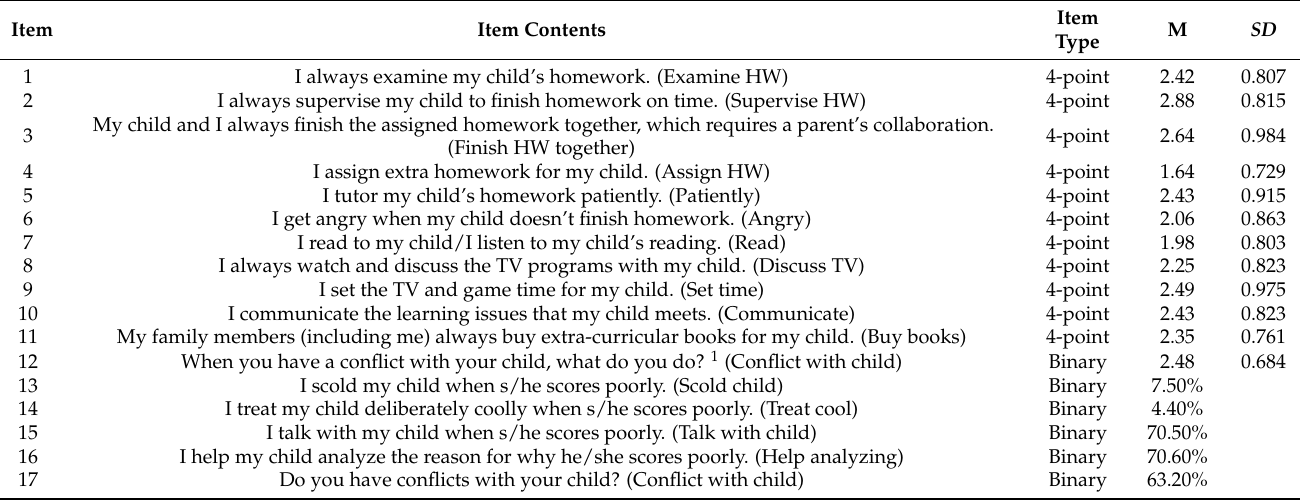
Table 1. Descriptive statistics on 17 indicator variables.